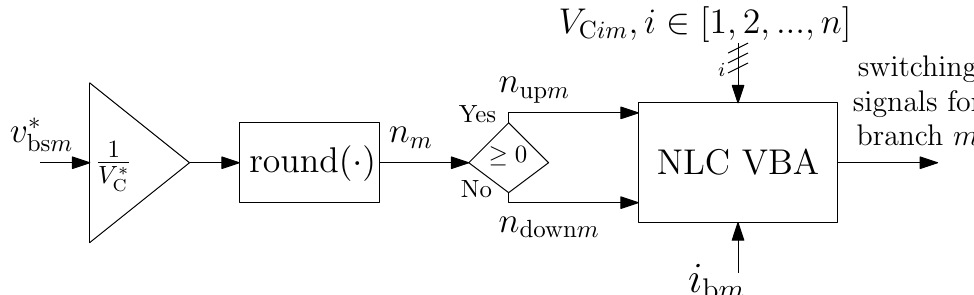
Figure 3. General flowchart of NLC modulation